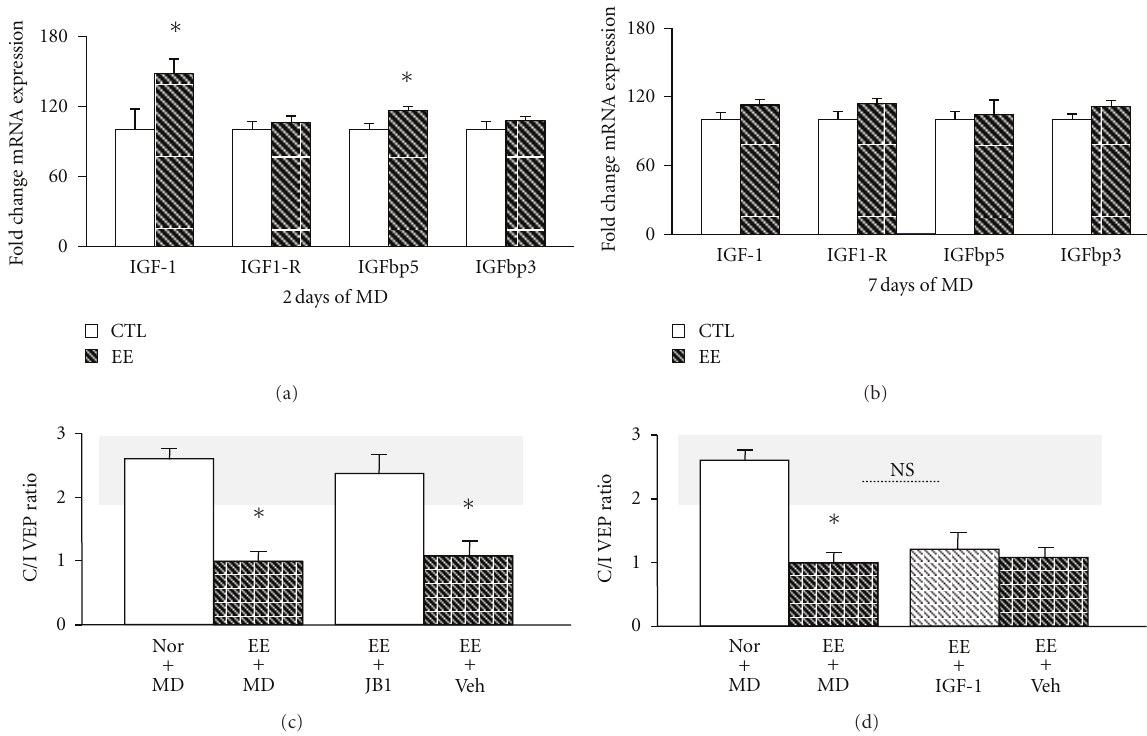
Figure 2: The upregulation of IGF-1 expression in EE animals mediates the e ff ects of enriched experience on adult VC plasticity. (a) Analysis of gene expression by RT-PCR revealed that IGF-1 and IGFbp5 expression increased in the VC of EE animals after 2 days of MD with respect to SC animals similarly treated ( n = 8 for both experimental groups; t -test; respectively, P = 0 . 034 and P = 0 . 030). In contrast, no modifications of either IGF1-R ( t -test; P = 0 . 523) or IGFbp3 ( t -test; P = 0 . 324) expression were detected. (b) The expression of IGF-1, IGF-1R, IGFbp5, and IGFbp3 in the VC was not di ff erent between EE animals monocularly deprived for 7 days and SC rats similarly treated. (c) JB1 infusion prevented the OD shift induced by MD in EE animals: no di ff erence in C/I VEP ratio between normal animals (Nor+MD; n = 5, 2.67 ± 0.15) and EE rats treated with JB1 subjected to MD detected (EE+JB1; n = 6; 2.37 ± 0.09; One-way ANOVA, post hoc Holm Sidak method), while monocularly deprived EE animals (EE+MD; n = 6; 0.99 ± 0.07) and EE rats treated with vehicle (EE+Veh; n = 5; 1.08 ± 0.05) showed an OD shift in favor of the open eye (One-way ANOVA, F (5–27) = 46.48, P < 0 . 0001, post hoc Holm Sidak method). (d) Coupling enriched experience with IGF-1 treatment (EE+IGF1 rats) did not further enhance the OD shift induced by MD in EE animals: the C/I VEP ratio measured in EE+IGF1 rats ( n = 5; 1.08 ± 0.07) was completely comparable to that reported for EE animals (EE+MD), while it di ff ered from that recorded in Nor+MD animals (One-way ANOVA F (5–27) = 46.48, P < 0 . 0001, post hoc Holm Sidak method). The grey box denotes the C/I VEP ratio range in adult normal animals. ∗ Statistical significance. NS: Not significant. Error bars indicate SEM.